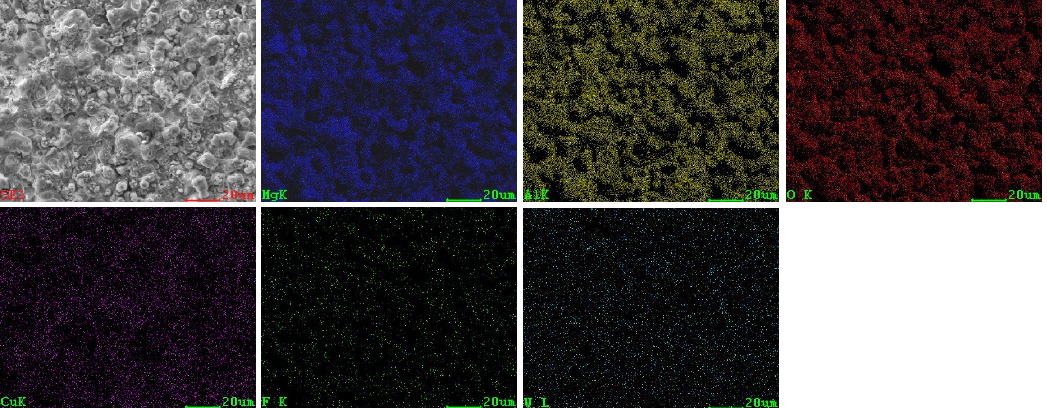
Figure 2. SEM surface micrographs and corresponding elemental distribution of sample 5 # . Table 3. EDS results of the coating surface (1 # –9 # ) prepared in different parameters.